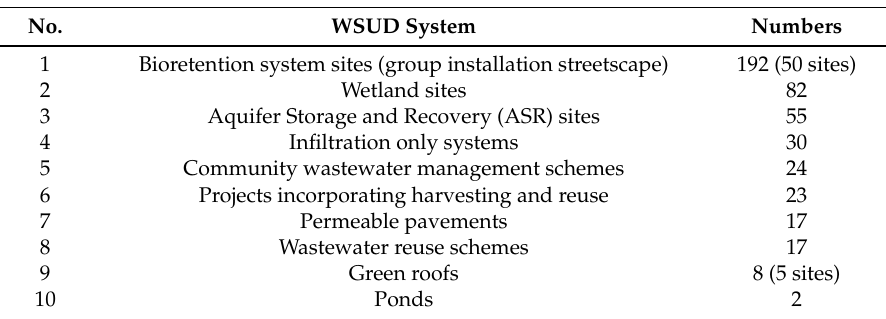
Table 2. Summary of WSUD